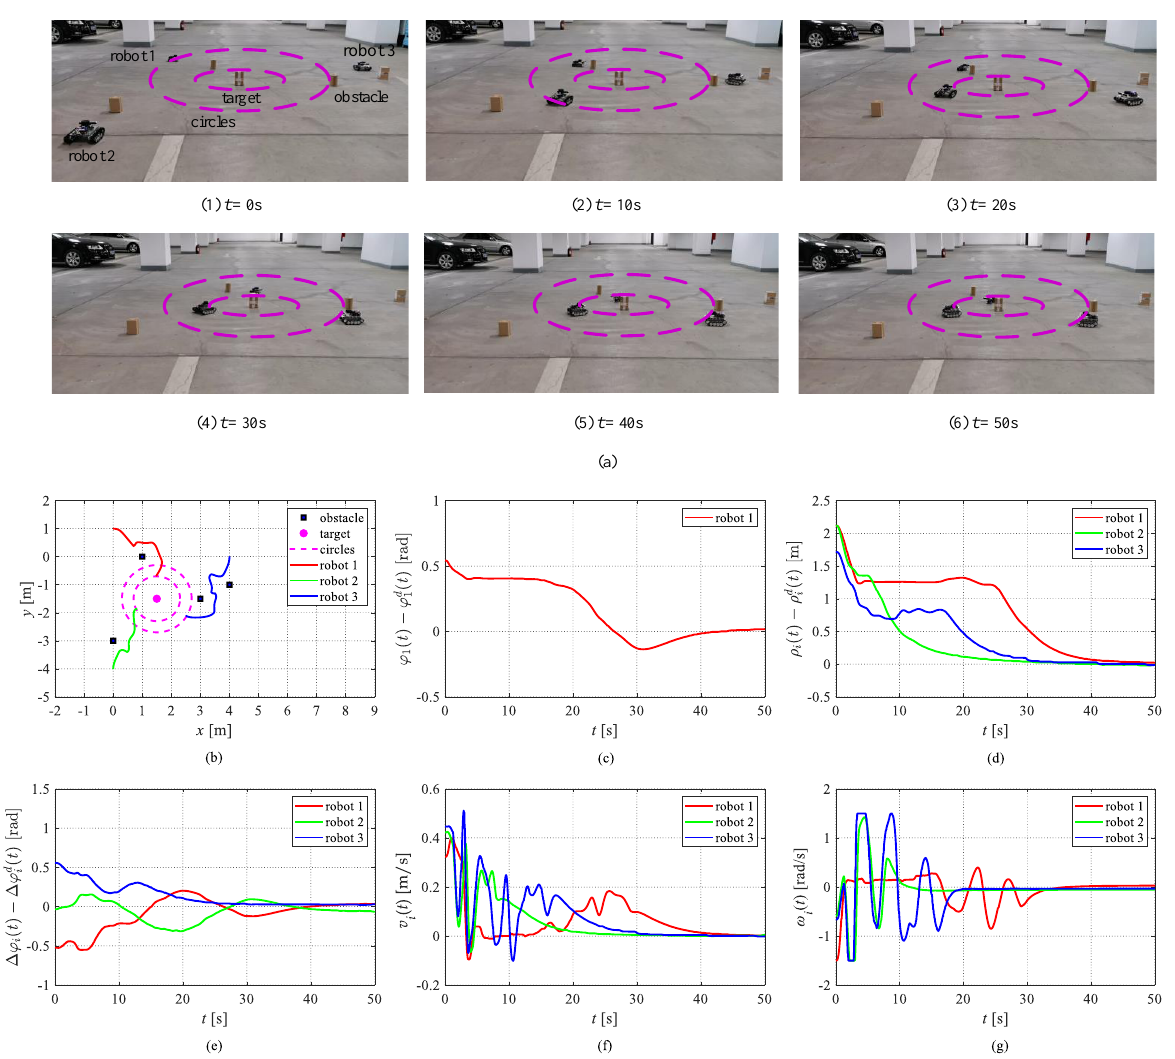
Figure 7. Experimental results of case 1. ( a ) The motion views of three nonholonomic mobile robots forming a evenly distributed circular formation with two different circular radii to enclose a static target. ( b ) Trajectories of the three robots and the target in the plane. ( c ) Error between current phase and the desired phase of robot 1. ( d ) Distance errors between the three robots and their desired circles centered on the target. ( e ) Errors between current angular spacing and the desired angular spacing of all adjacent inter-robots. ( f ) The linear speeds of the three robots. ( g ) The angular speeds of the three